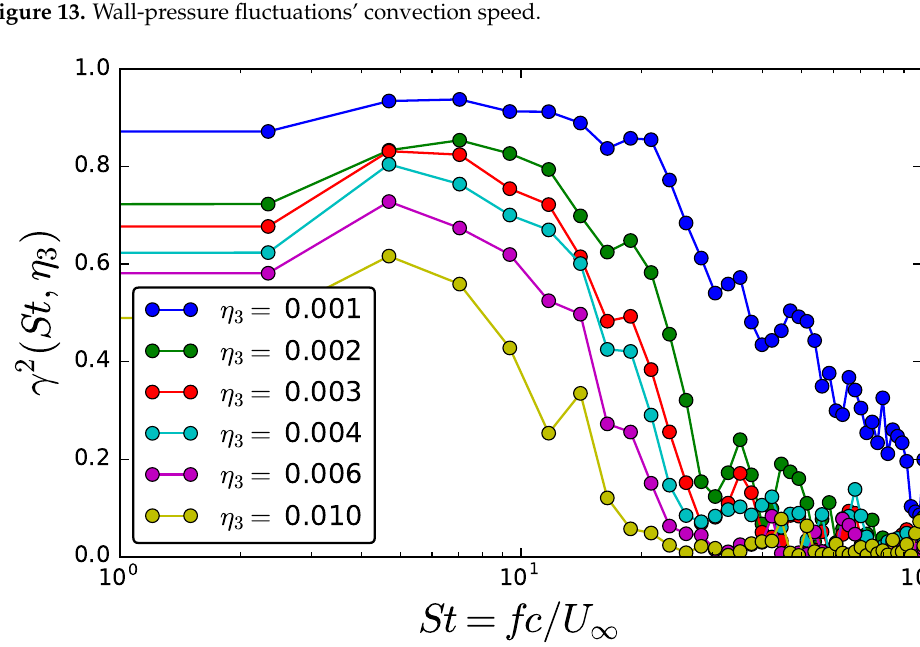
Figure 14. Wall-pressure transverse coherence